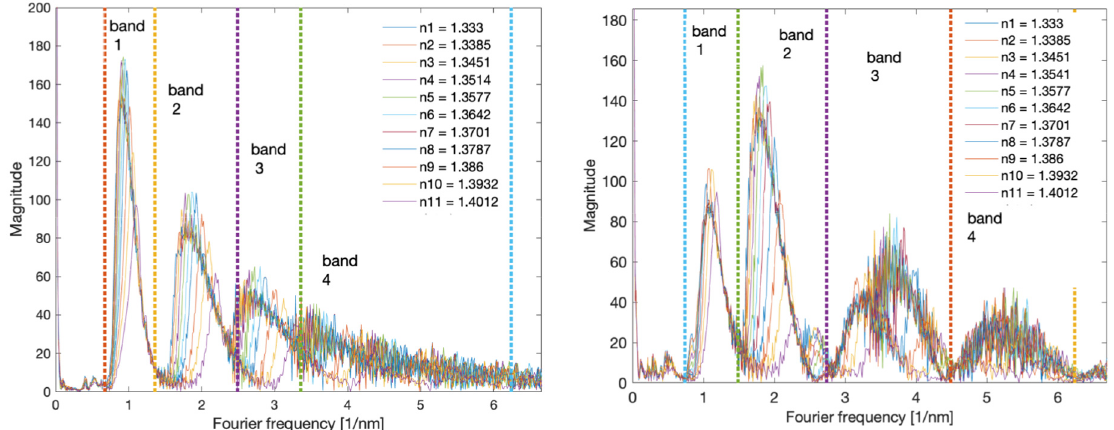
Figure 8. Comparison of Fourier spectra of TFBG and DC-TFB gratings for individual SRIs.